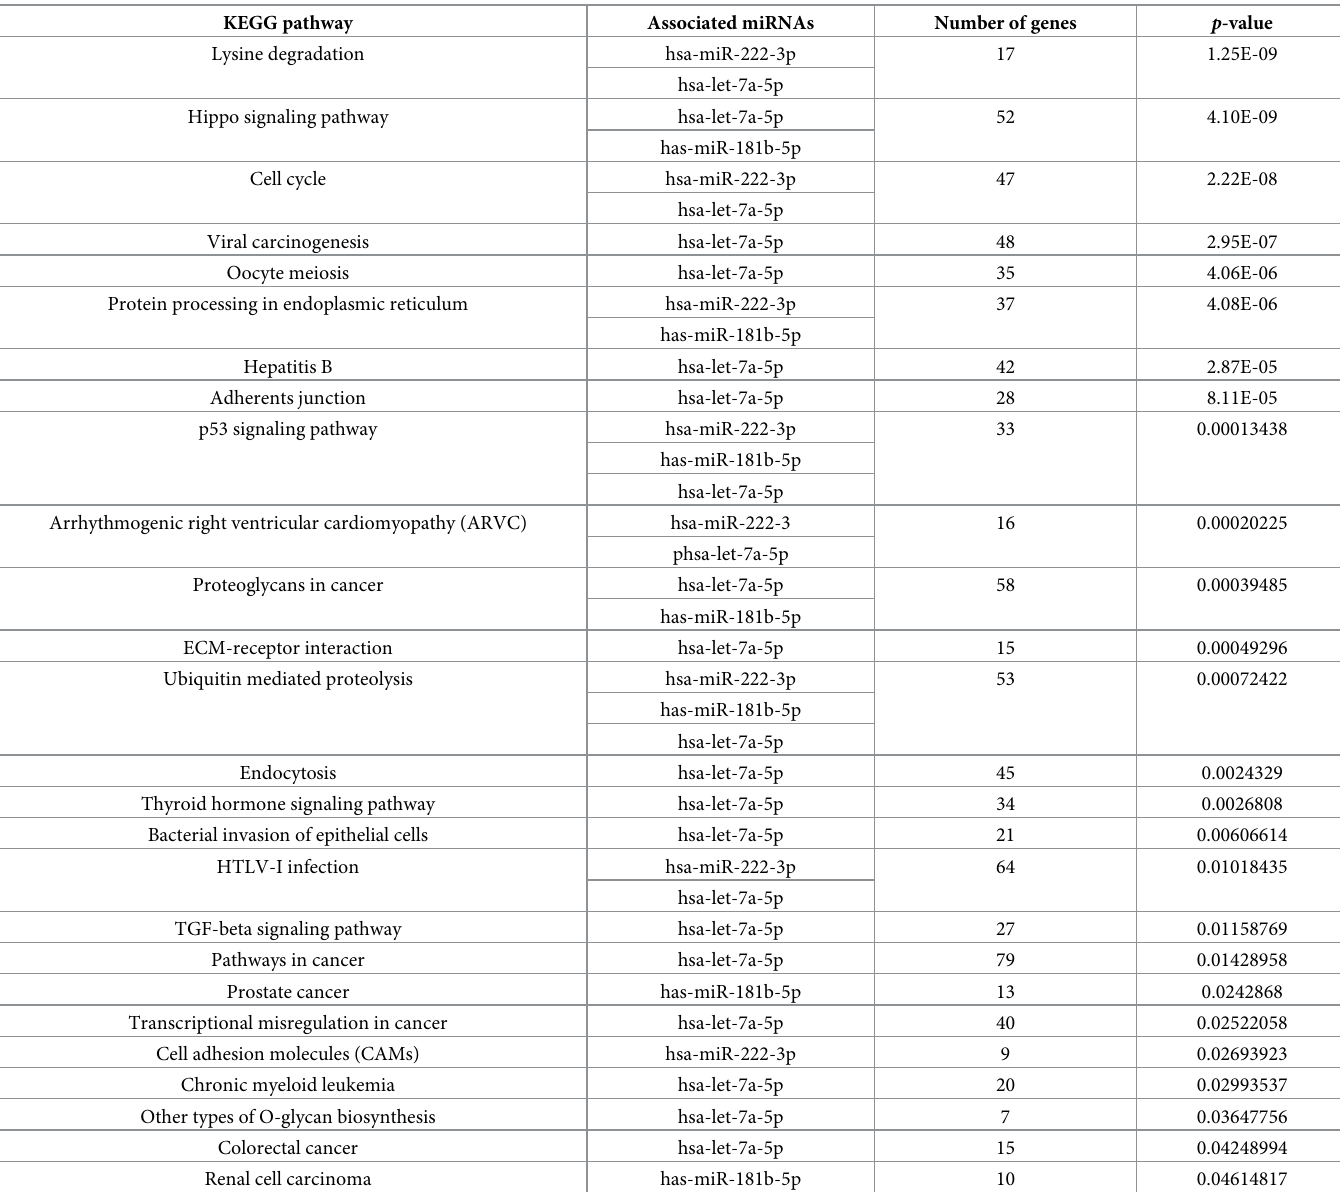
Table 7. Kyoto Encyclopedia of Genes and Genomes (KEGG) pathways associated with miR-181b-5p, miR-222-3p, and